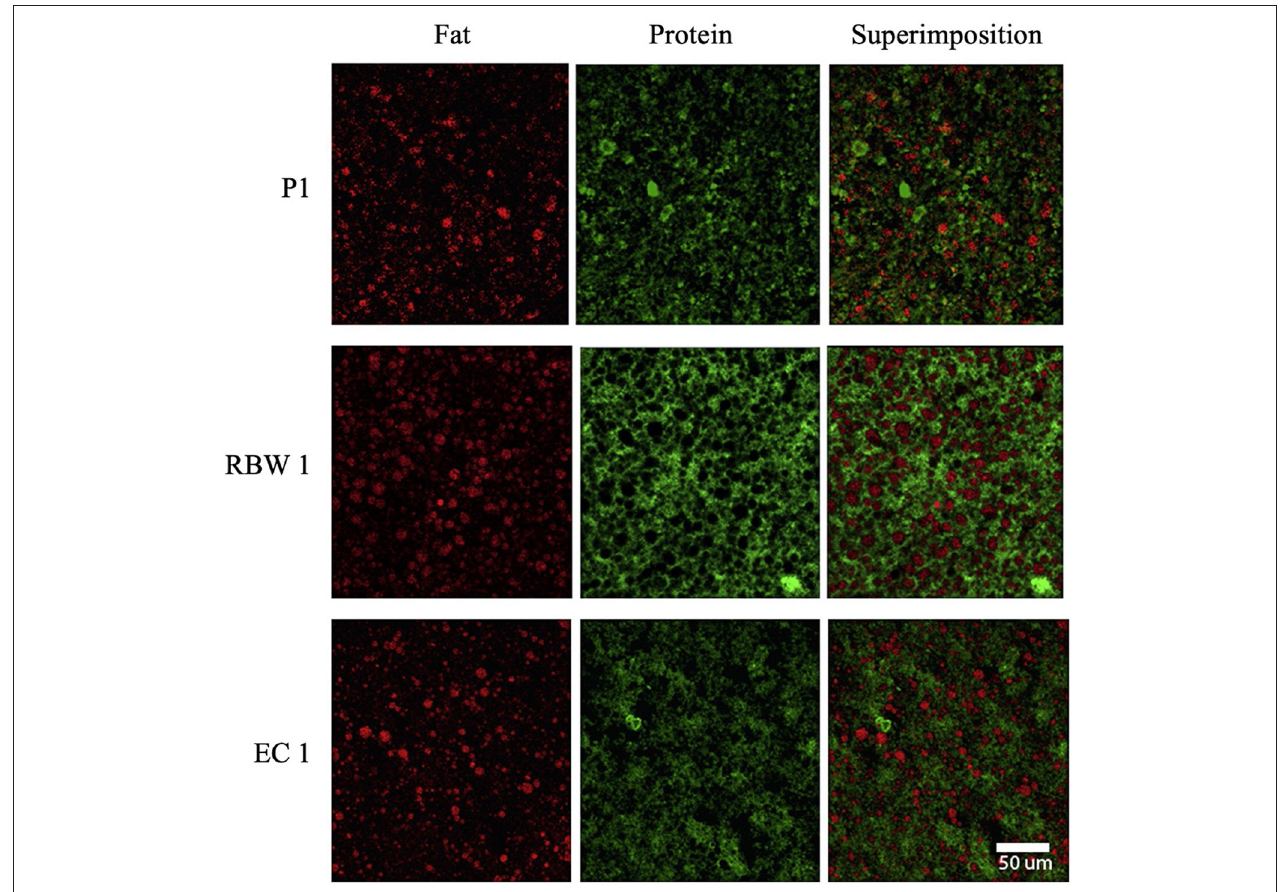
FIGURE 1 | Microstructure of commercial cream cheese (P1) and rice bran wax (RBW 1) and ethylcellulose (EC 1) oleogel cream cheese products. Lipids and proteins shown in red and green, respectively. Adopted from Bemer et al. (2016) with permission from Elsevier.